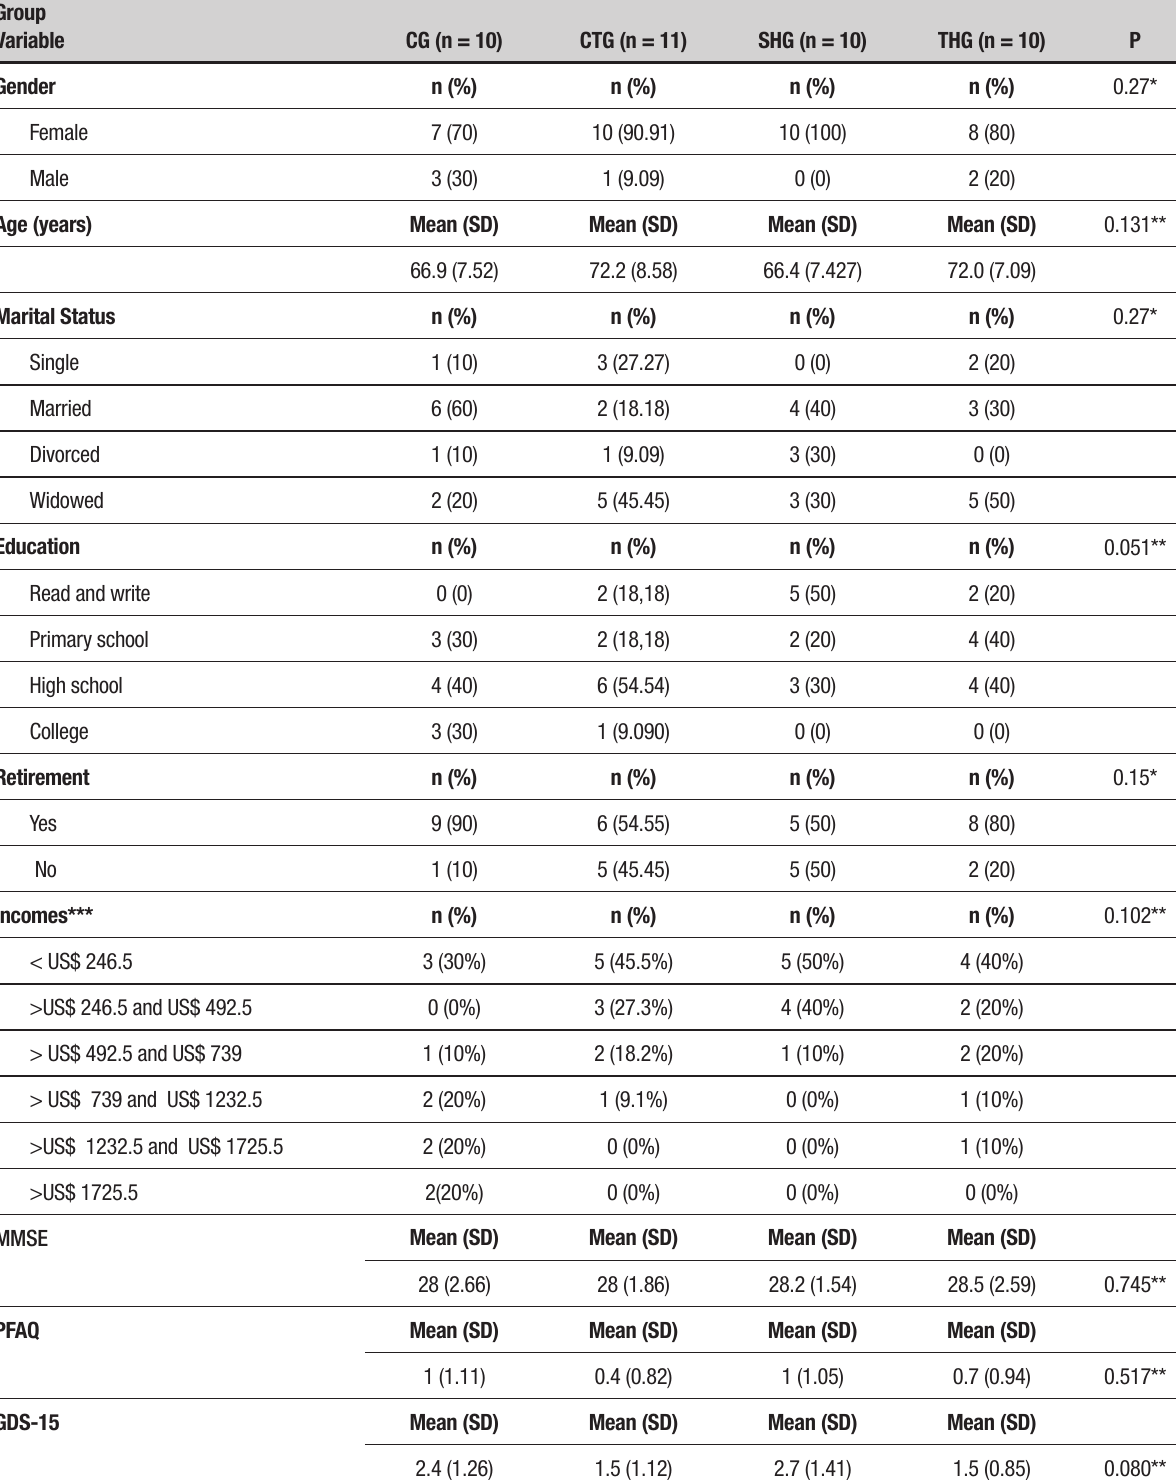
Table 1. Sociodemographic characteristics and screening for cognitive impairment, depressive symptoms and functioning.